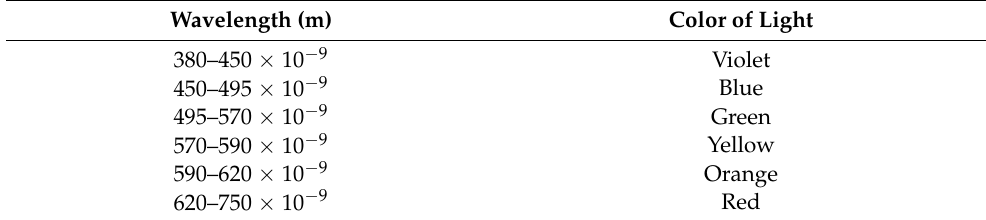
Table 1. The Wavelength of Different Colours of